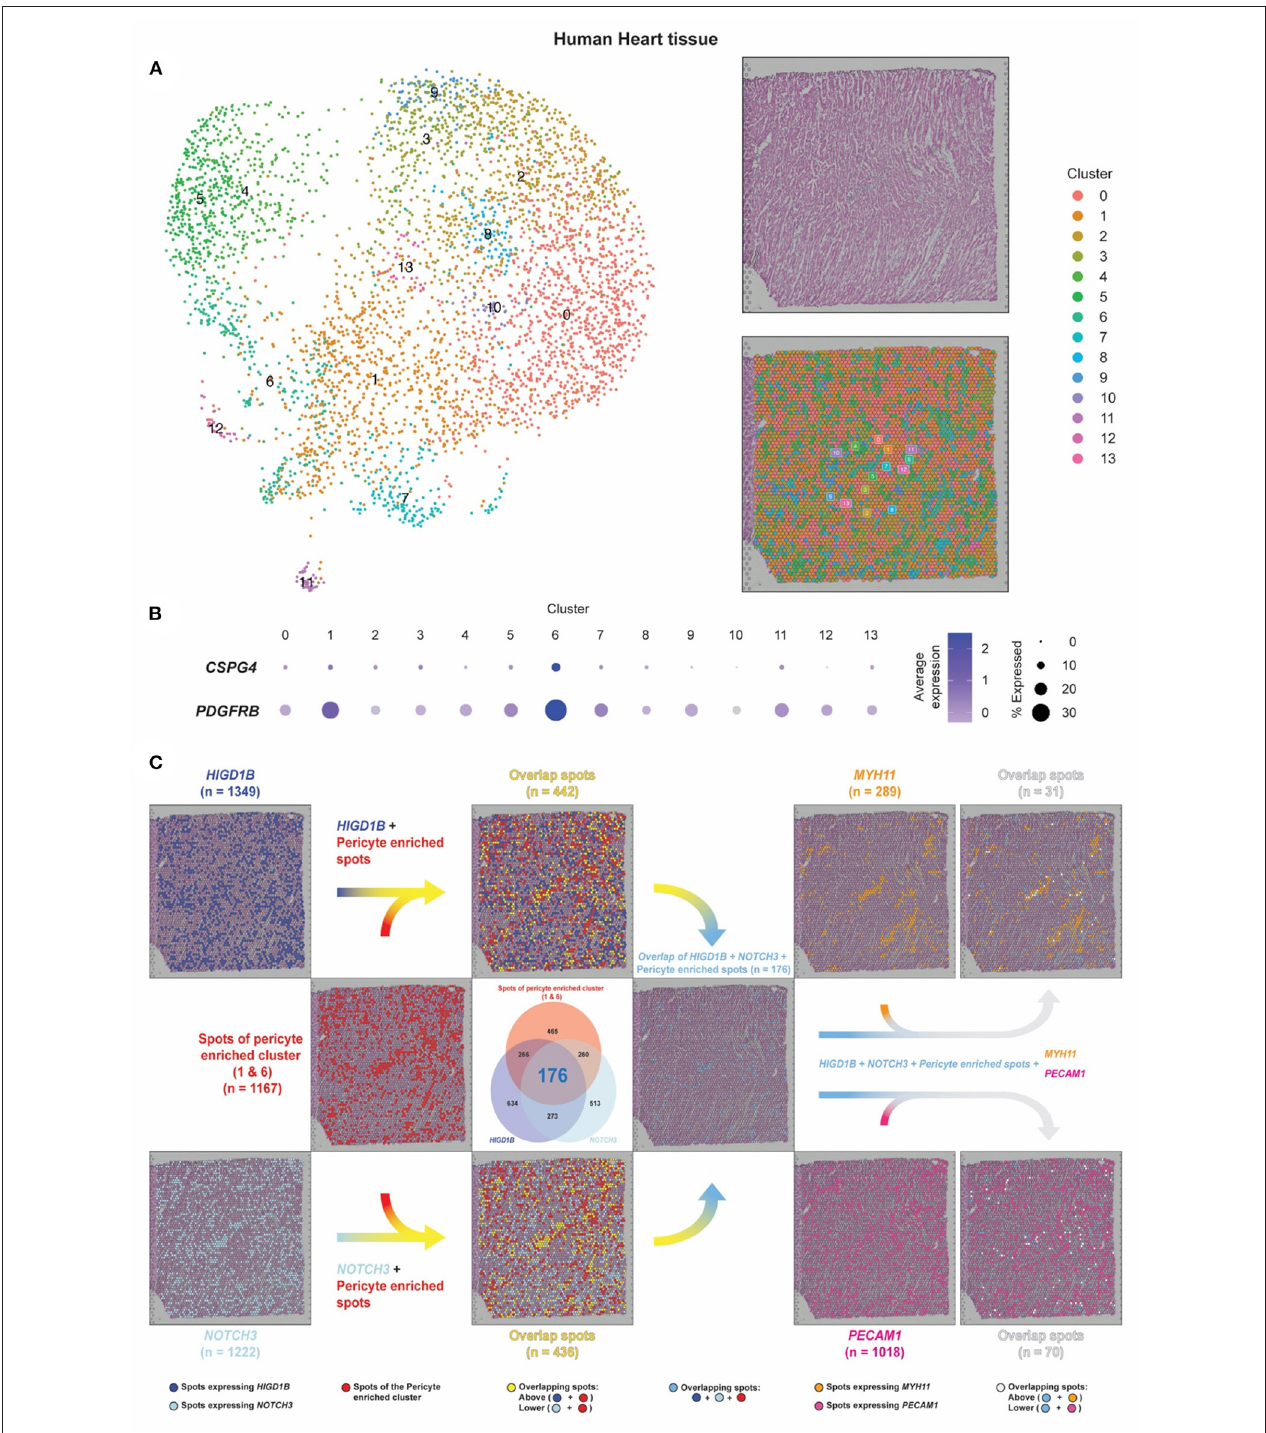
FIGURE 5 | Pericyte transcripts locate on capillaries in human heart tissue by spatial transcriptomic analysis. (A) The spatial transcriptomic data of the human heart tissue from the Spatial Gene Expression Dataset by 10 × Genomics Space Ranger (10 × Genomics Space Ranger 1.1.0) was used to investigate the pericyte spatial localization within the heart tissue and compare it with regions of the capillaries and the arteries. (B,C) Based on the expression of CSPG4 and PDGFRB , spots of clusters 1/6 were designated as pericyte spots (shown as red dots). Dark blue dots indicate spots that express HIGD1B. Cyan dots indicate spots that express NOTCH3 . Sky blue dots indicate spots that co-express HIGD1B and NOTCH3 among the pericyte spots. Spots that expressed MYH11 were identified as smooth muscle coverage of arteries (shown as orange dots). Spots that expressed PECAM1 were identified as endothelial cells and capillary lumens (shown as dark pink dots).